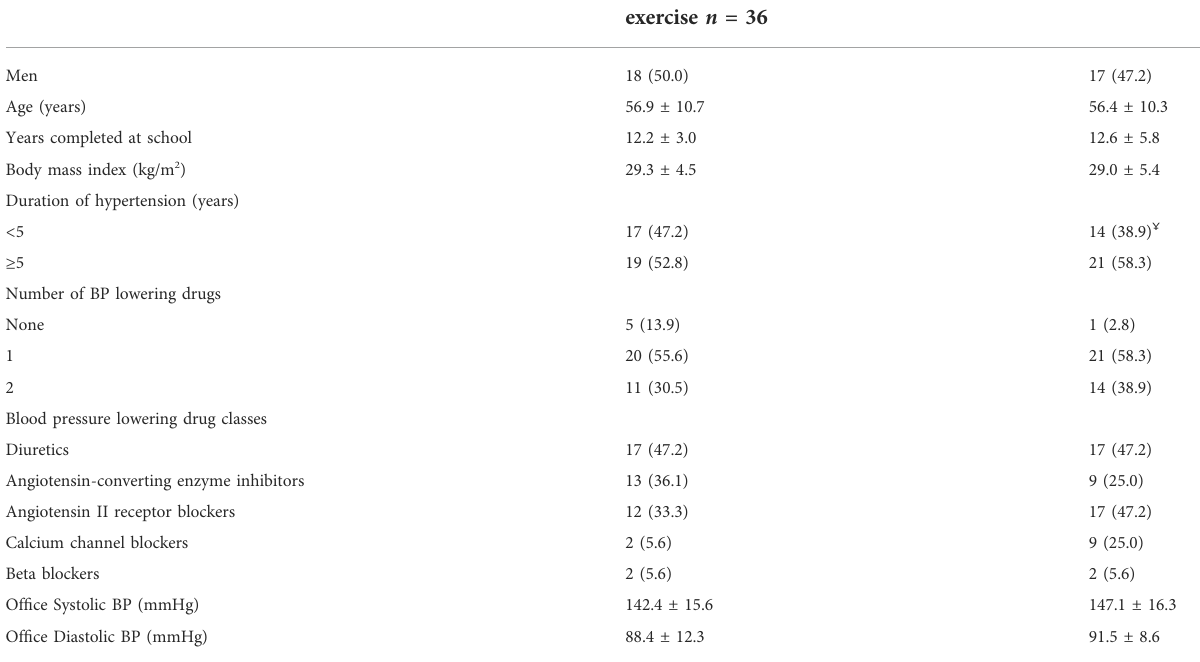
TABLE 1 Characteristics of the participants at the baseline according to the allocation